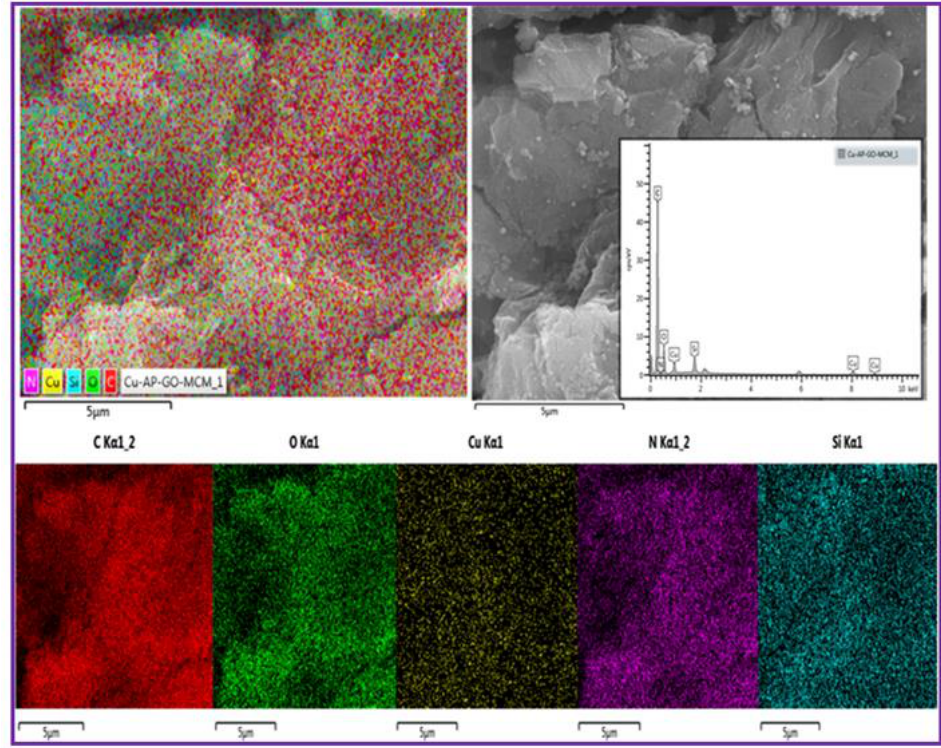
Figure 5. SEM/EDX images of the 5Cu(0)-AAPTMS@RGO-MCM-41 sample.